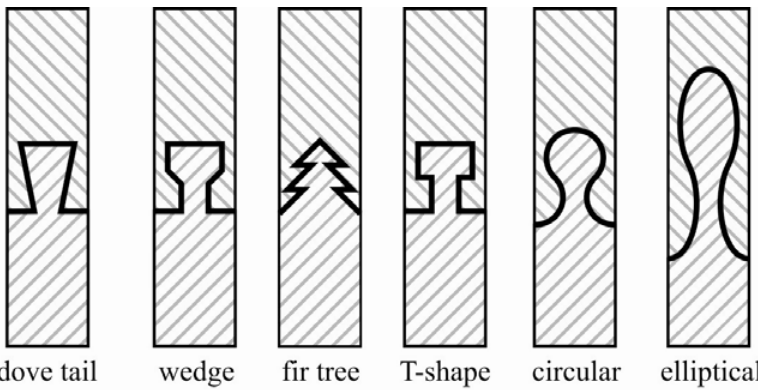
Figure 2. Elementary shapes of basic connecting elements.